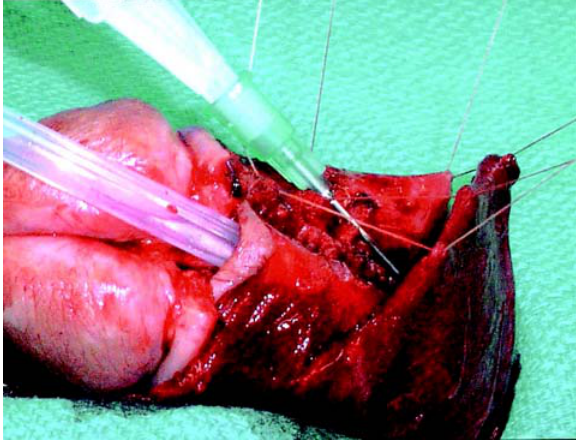
Figure 3 – Application of fibrin sealant as a bolster over the suture line of pendulous urethroplasty. Redundant tunica dartos pedicle is glued in place over suture